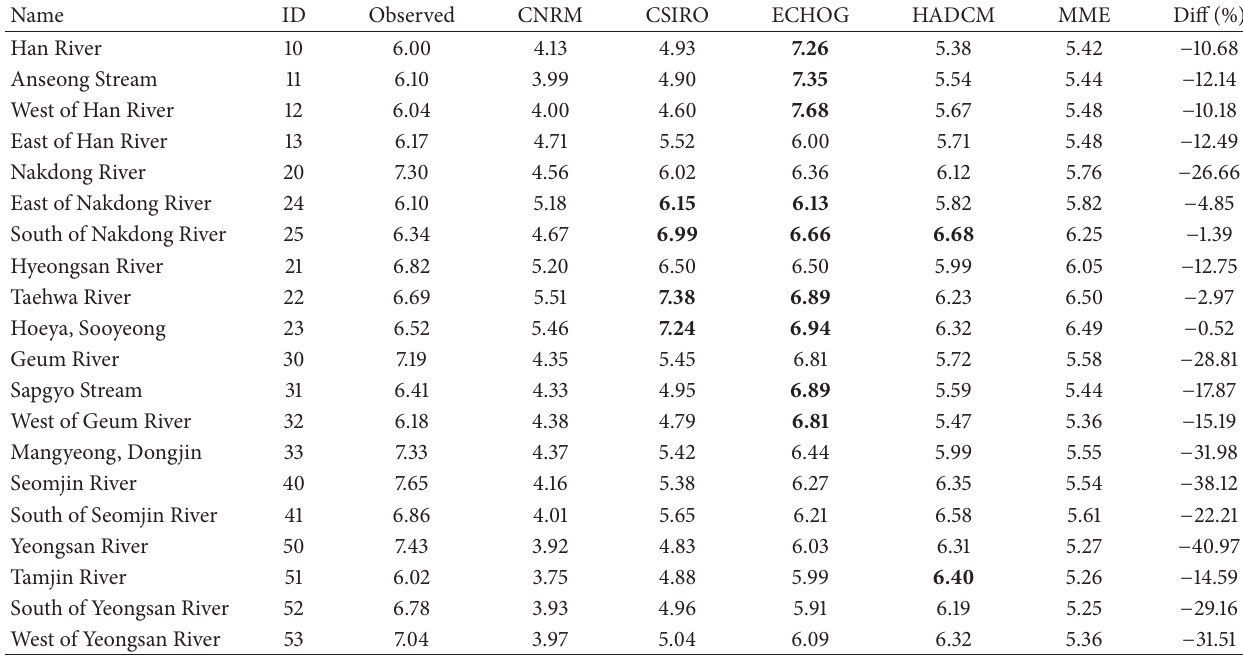
Table 5: Changes in the frequency in severe dry stages with three-month SPI less than − 1.5 for past and future climate change projections. Observed frequency of severe drought for the period 1976–2010 and projected change in frequency of severe drought by each GCM and MME average for the period 2011–2099 for the climate change scenario. Difference is a percentage change in drought frequency between past and future periods, and positive value indicates increasing trend and vice versa. Note that the SPI series is calculated from a downscaled monthly precipitation using the four GCMs as inputs.